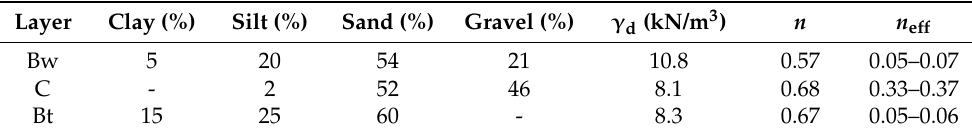
Table 1. Physical characteristics of the pyroclastic soil: Bw, weathered and remolded ash deposits; C, pumice level; Bt, weathered ash level; clay, silt, sand and gravel, fraction; γ d , unit weight of dry soil; n , total porosity; n eff , effective porosity (extracted from Reference [4]). Layer Clay (%) Silt (%) Sand (%) Gravel (%) γ d (kN/m 3 ) n n eff Bw 5